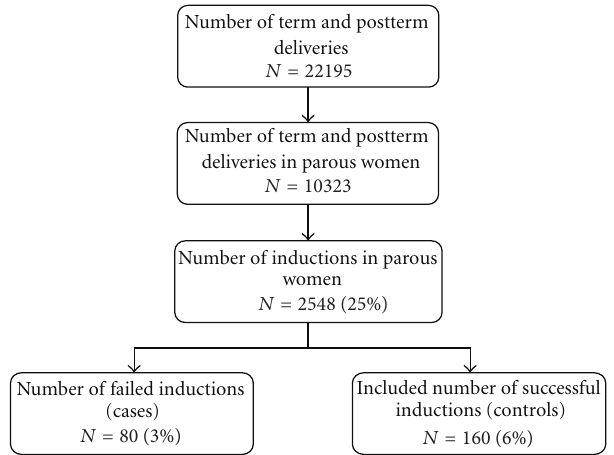
F 1: Flowchart of the study group: total number of term and postterm deliveries and inductions of labor between 1995 and 2010 in Máxima Medical